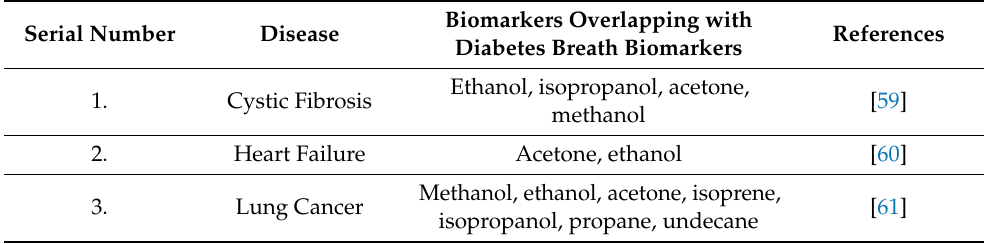
Table 2. Diseases with Breath Biomarkers Overlapping with Diabetes Breath Biomarkers.